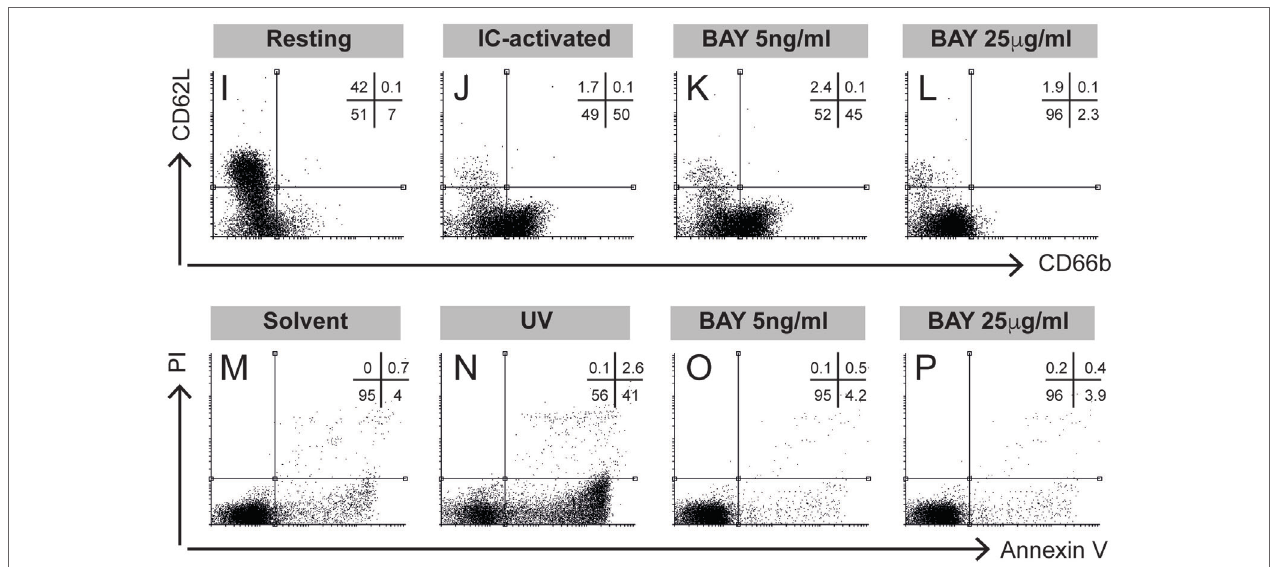
FigUre 6 | Pharmacological inhibition of SYK blocks immune complex (IC)-induced activation of polymorphonuclear leukocytes (PMNs) in vitro and ex vivo . (a) Human PMNs were activated using IgG-ICs, and their activation was determined by measuring the release of reactive oxygen species (ROS). The data ( n = 11–30/group) were normalized to IC-activated PMNs in the presence of solvent (water) and are displayed as the median (black line), the 27/75 percentiles (box), and the 5/95 percentiles (error bars). BAY61-3606 reduced the release of ROS from IC-activated PMNs in a dose-dependent manner (ANOVA on Ranks with Dunn’s post-test). (B) Representative ROS release expressed as counts per second (CPS) over the 60-min experimental period. (c) Human PMNs were activated using IgA-ICs, and their activation was determined by measuring the release of ROS. The data ( n = 6/group) were normalized to the IC-activated PMNs in the presence of solvent (water) and are displayed as the median (black line), the 27/75 percentiles (box), and the 5/95 percentiles (error bars). BAY61-3606 reduced the release of ROS from IC-activated PMNs in a dose-dependent manner (ANOVA on Ranks with Dunn’s post-test). (D) Representative ROS release expressed as CPS over the 60 min experiment. (e) BAY61-3606 also ablates dermal–epidermal separation in cryosections of human skin incubated with anti-type VII collagen (COL7) IgG and PMNs. The data are presented as the mean (boxes) and STD (error bars) and are based on five experiments per group. To calculate whether the effects of BAY61-3606 were significant, ANOVA with Ranks and Dunn’s post-test was used. (F–h) Representative images of the cryosection assay at a 200 × original magnification showing (F) no dermal–epidermal separation in the sections incubated with normal human serum (NHS) and PMNs, (g) no dermal–epidermal separation in the sections incubated with anti-COL7 IgG, and (h) no dermal–epidermal separation in the sections incubated with anti-COL7 IgG, PMNs, and 25 mg/ml BAY61-3606. (i–l) Representative experiments evaluating the expression of CD66b ( x -axis) and L-selectin (CD62L, y -axis) in immune complex-stimulated PMNs. (i) CD66b and CD62L expression in resting PMNs show low expression of CD66b and high expression of CD62L. Data are based on five experiments per group. (J) By contrast, IC activation leads to L-selectin shedding and increased CD66b expression. (K) Low concentrations of BAY61-3606 had no impact on the IC-induced changes in PMN surface molecule expression. (l) Higher compound concentrations normalized CD66b expression, but had no effect on L-selectin sheading. (M–P) These effects of BAY61-3606 were achieved at non-toxic concentrations, as evaluated by annexin V/propidium iodine staining. Representative results from (M) solvent- (water), (n) UV-irradiated- (positive control), and (O,P) BAY-61-3606-treated activated PMNs.